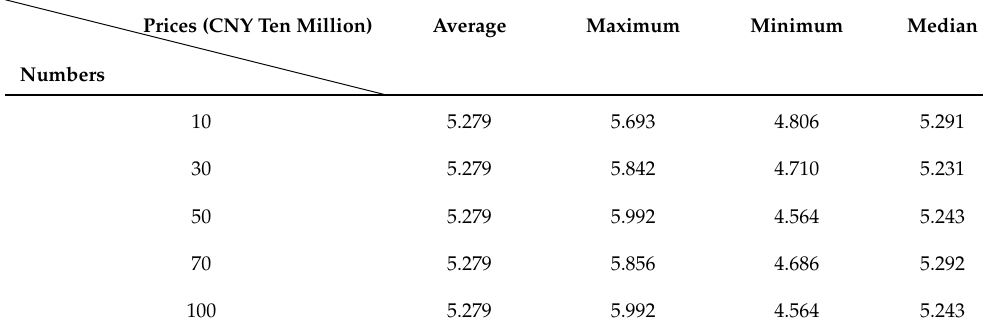
Table 2. The bidding prices of competitors.